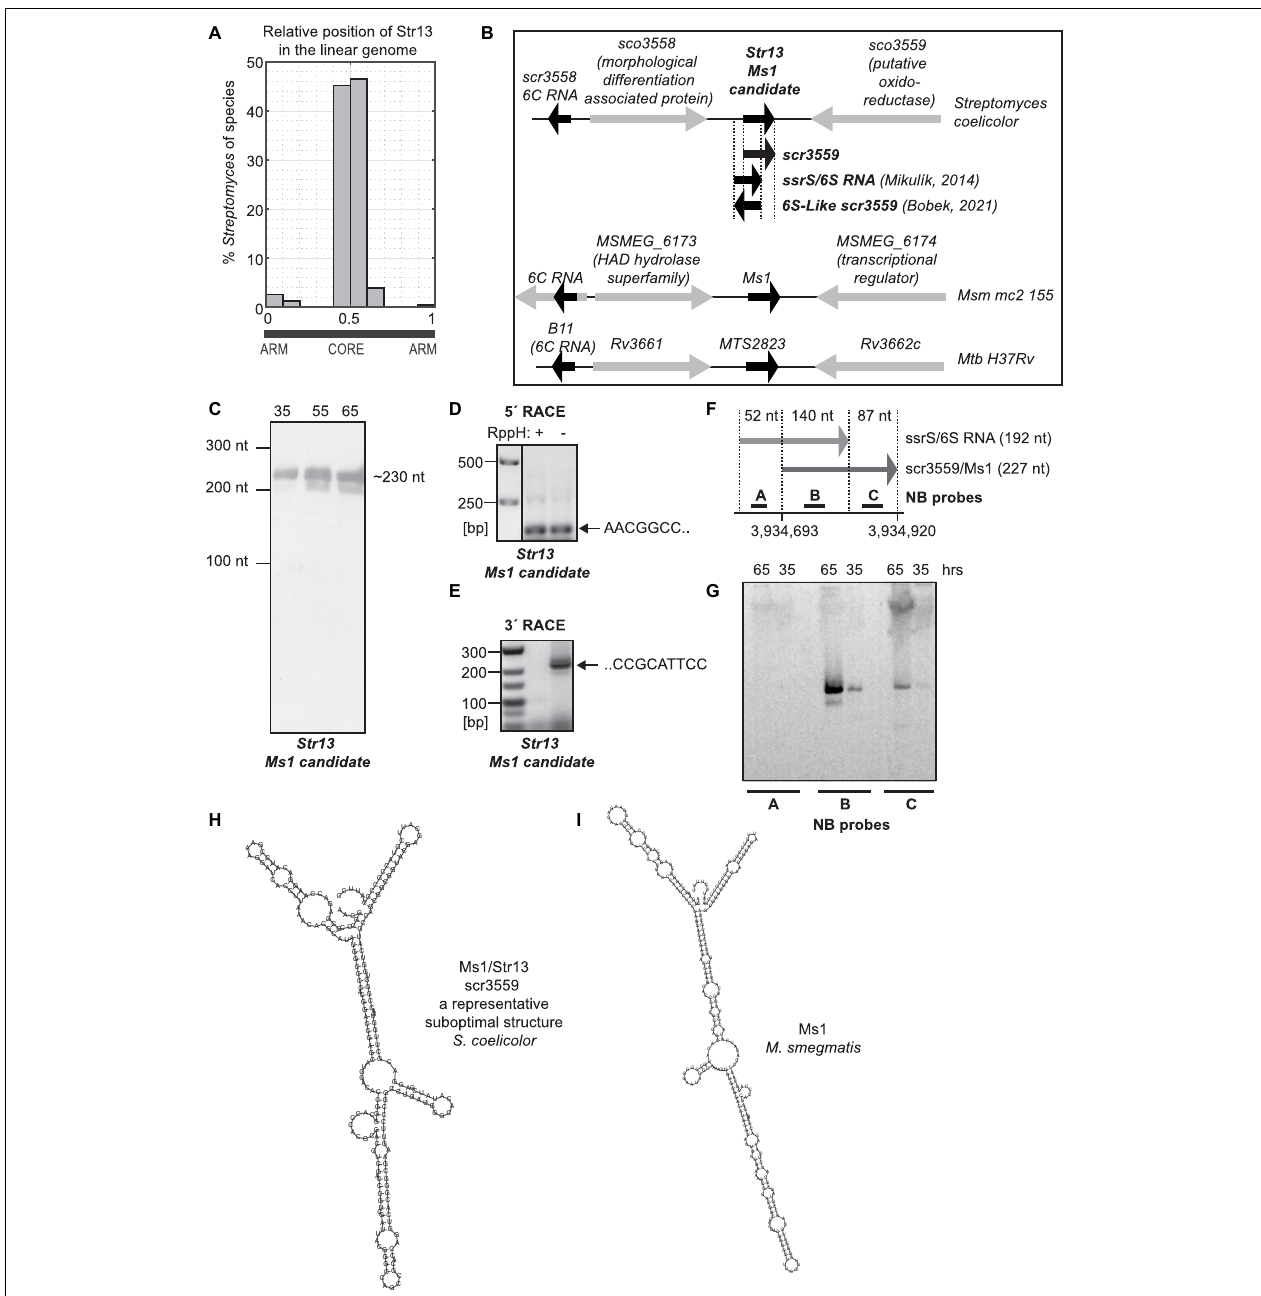
FIGURE 2 | S. coelicolor Ms1 RNA candidate. (A) Histogram of relative genomic position of a Ms1 candidate, Str13, in 188 Streptomyces species. x -axis shows a relative genomic position with “0” and “1” corresponding to the terminal arms of the linear Streptomyces genome and with “0.5” corresponding to the middle of Streptomyces linear genome. y -axis shows percentage of 188 Streptomyces species in which Str13 homologs were identified using sequence similarity. The figure indicates that the Str13 relative genomic position is conserved in the middle of the linear Streptomyces genomes. (B) Ms1 candidate in S. coelicolor , Ms1 in M. smegmatis and MTS2823 Ms1 homolog in M. tuberculosis and their flanking genes. In Streptomyces coelicolor , positions of the previously published sRNAs are also included. The position of 6S-Like scr3559 was adopted from the 6S-Like scr3559 sequence reported in Figure 2B of Bobek et al. (2021). The position of ssrS /6S RNA was adopted from Mikulík et al. (2014), from the sequences of primers that were used to generate DNA template carrying T7 promoter for in vitro transcription of 6S RNA. Experiments showing 6S RNA—RNAP interaction were performed with this in vitro transcribed RNA. scr3559 position was adopted form available S. coelicolor dRNA-seq data (Romero et al., 2014; Jeong et al., 2016; Kim et al., 2020) and RNA-seq data (Vockenhuber et al., 2011; Moody et al., 2013). (C) ∼ 230 nt long RNA was detected by Northern blotting with the probe specific to Ms1 candidate/scr3559/(probe 2796). The 5 (cid:48) end of Ms1 candidate was determined by 5 (cid:48) RACE (D) , 3 (cid:48) end by 3 (cid:48) RACE (E) and corresponds to the scr3559 sRNA (F) . 6S RNA expression was not detected by Northern blotting (G) . (H) Structure of scr3559. (I) Structure of Ms1 RNA from M. smegmatis .